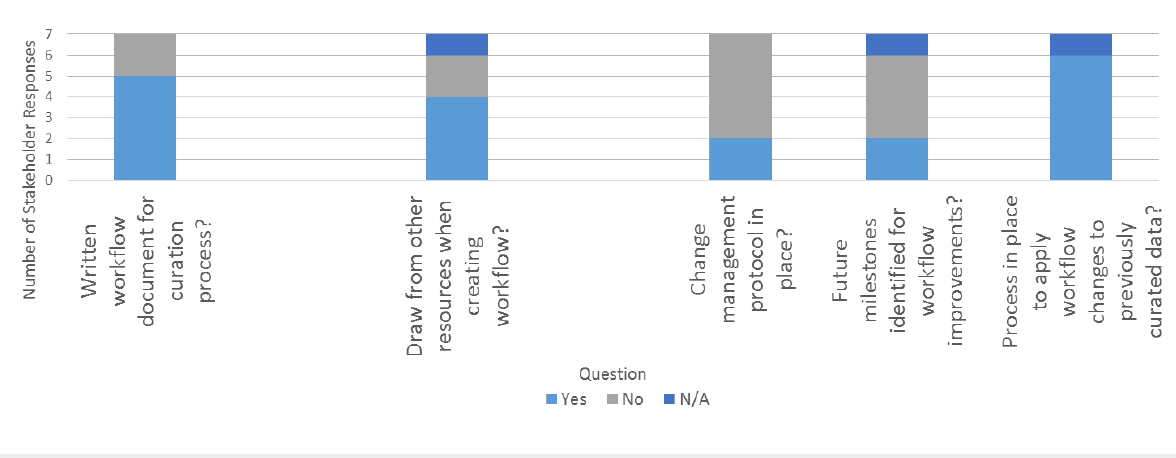
Figure 4: Stakeholder responses regarding creation and revision. Stakeholder responses to questions related to creating and revising a written workflow. Full text of stakeholder responses is available in the Supporting Information File 1.